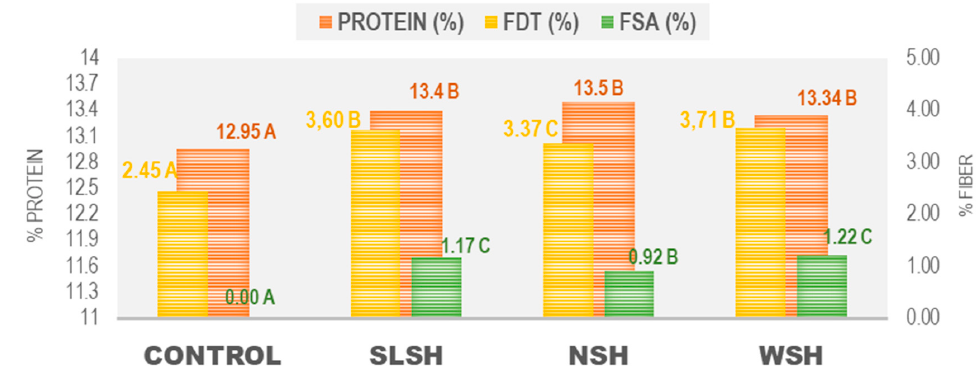
Figure 1. Protein content and fiber (%) in the different types of pasta. FDT: Total dietary fiber; FSA: Soluble fiber; SLSH: Sea lettuce shiitake; NSH: Nori shiitake; WSH Wakame shiitake. Different letters indicate significant differences ( p < 0.05) among all the pastas.